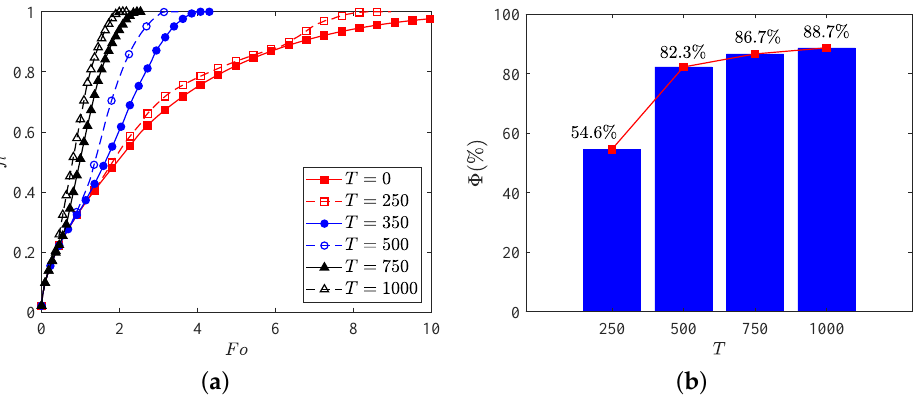
Figure 7. ( a ) Time evolution of the total liquid fraction f l , and ( b ) the the charging time reduction for different electric Rayleigh number. Parameters: Ra = 10,000, AR =